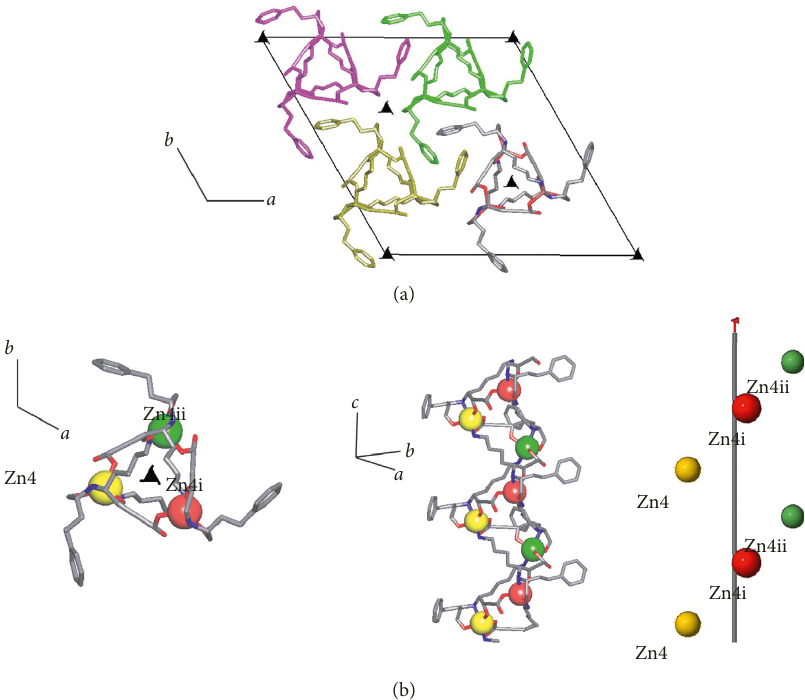
Figure 8: (a) Unit cell and space group diagram within four one-dimensional chains for structure. (b) Zn4–Zn4 coordinate bond motifs that propagate along a 3 2 screw axis parallel to the c -axis crystallographic. Symmetry codes: (i) atoms were omitted for more